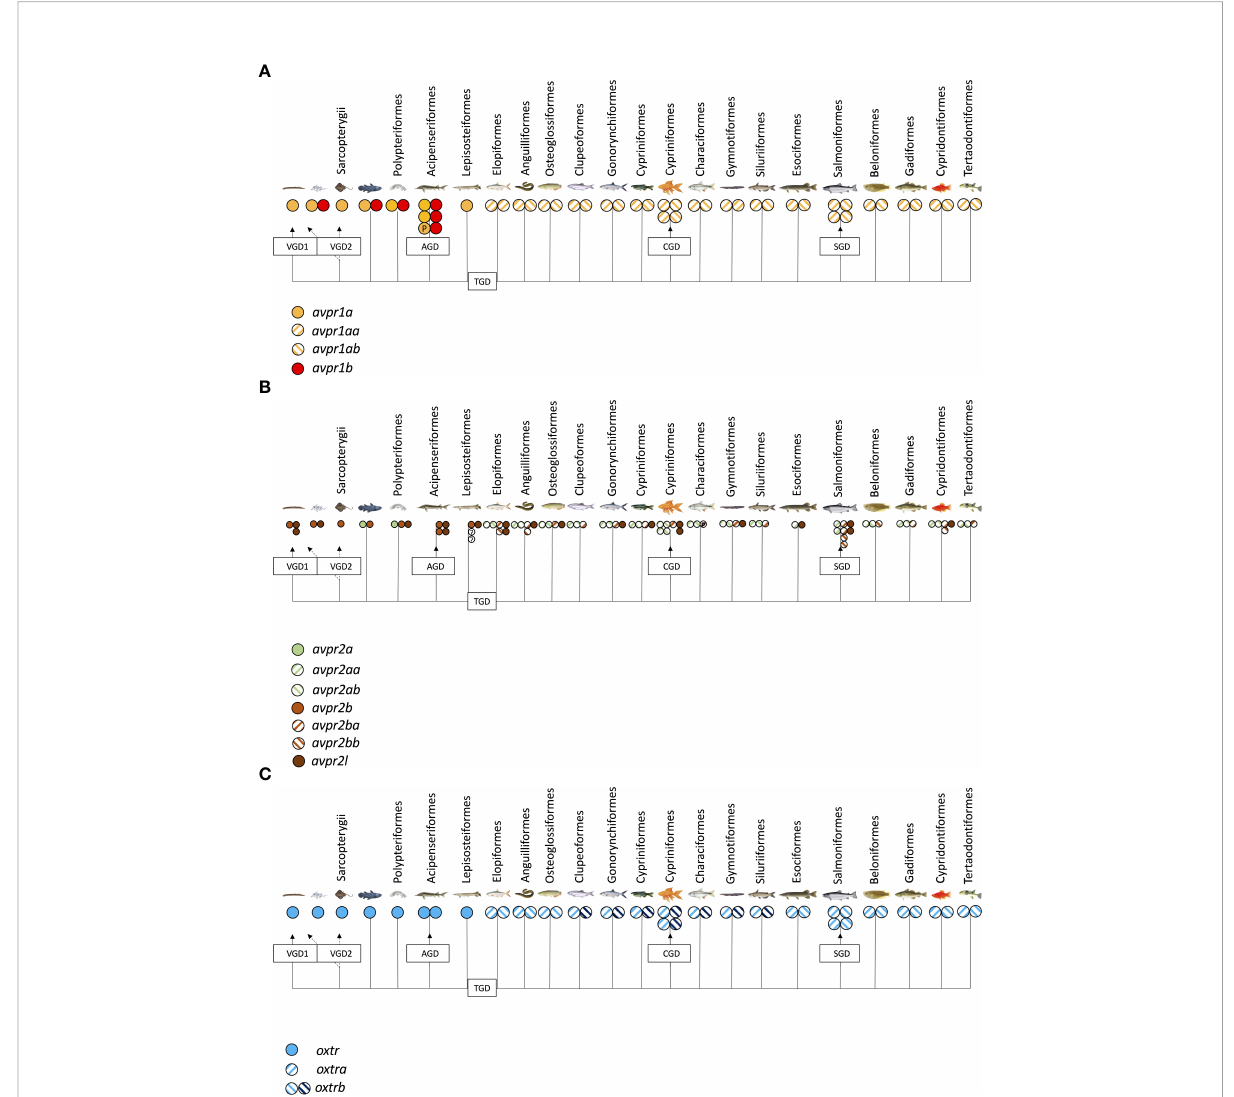
FIGURE 2 Presence of avpr1 (A) , avpr2/avpr2l (B) and oxtr (C) genes in published fi sh genomes accessed on NCBI (www.pubmed.com) on June 1 st ,